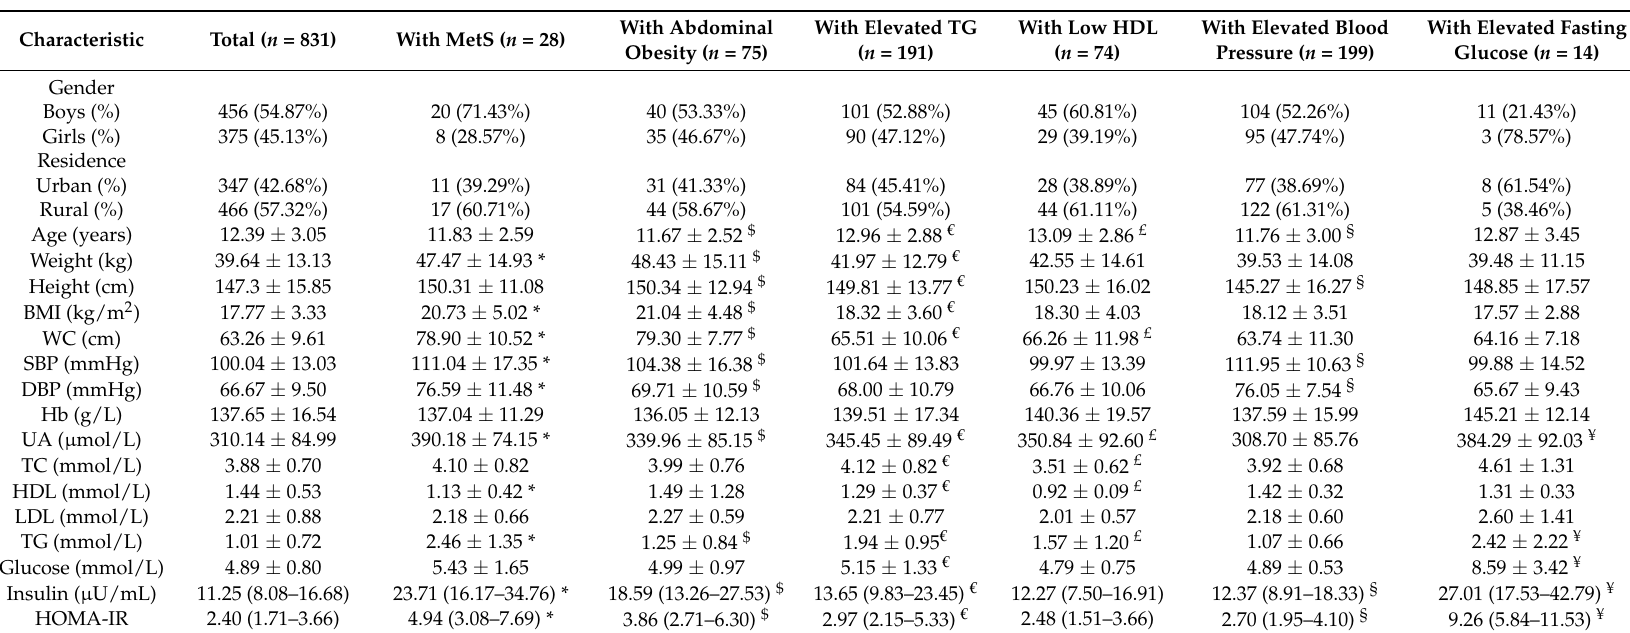
Table 2. Basic characteristics of the study subjects by presence of metabolic syndrome (MetS) and its components using the National Cholesterol Education Program Adult Treatment Panel III (NCEP-ATP III)